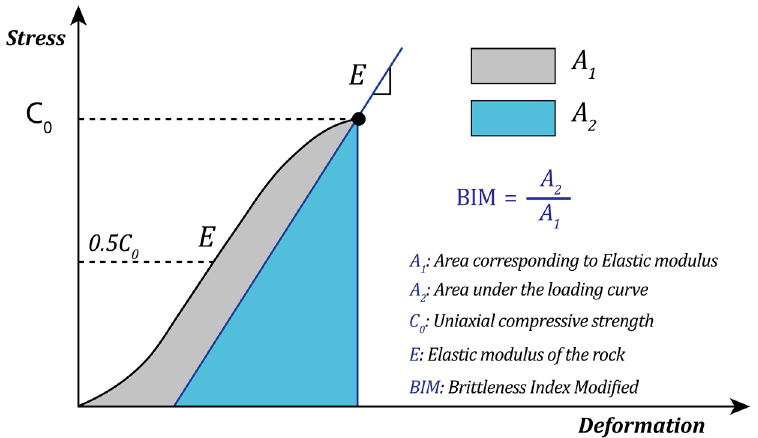
Figure 11. BIM determination using uniaxial compression testing (Modified after ref. [155]). Table 7. BIM indicative values and risk of violent rupture [155]. BIM Elastic Strain Energy Between 1.00 and 1.20 High Between 1.20 and 1.50 Moderate More than 1.50